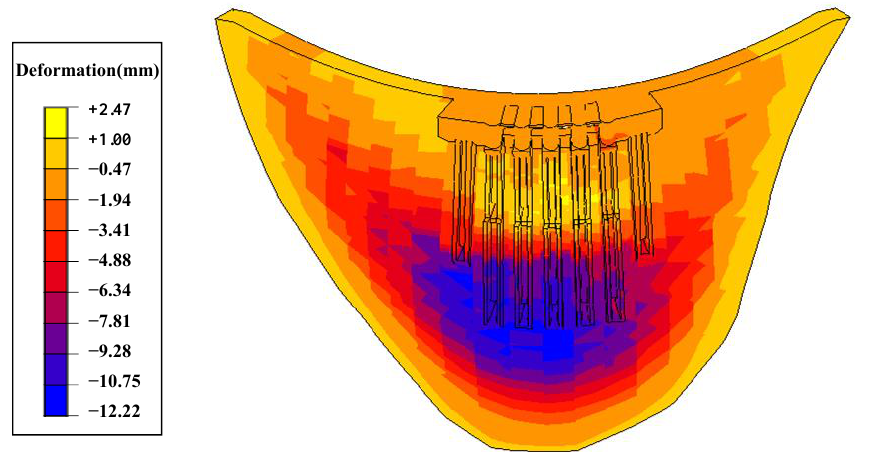
Figure 31. Radial deformation of the super-high arch dam.